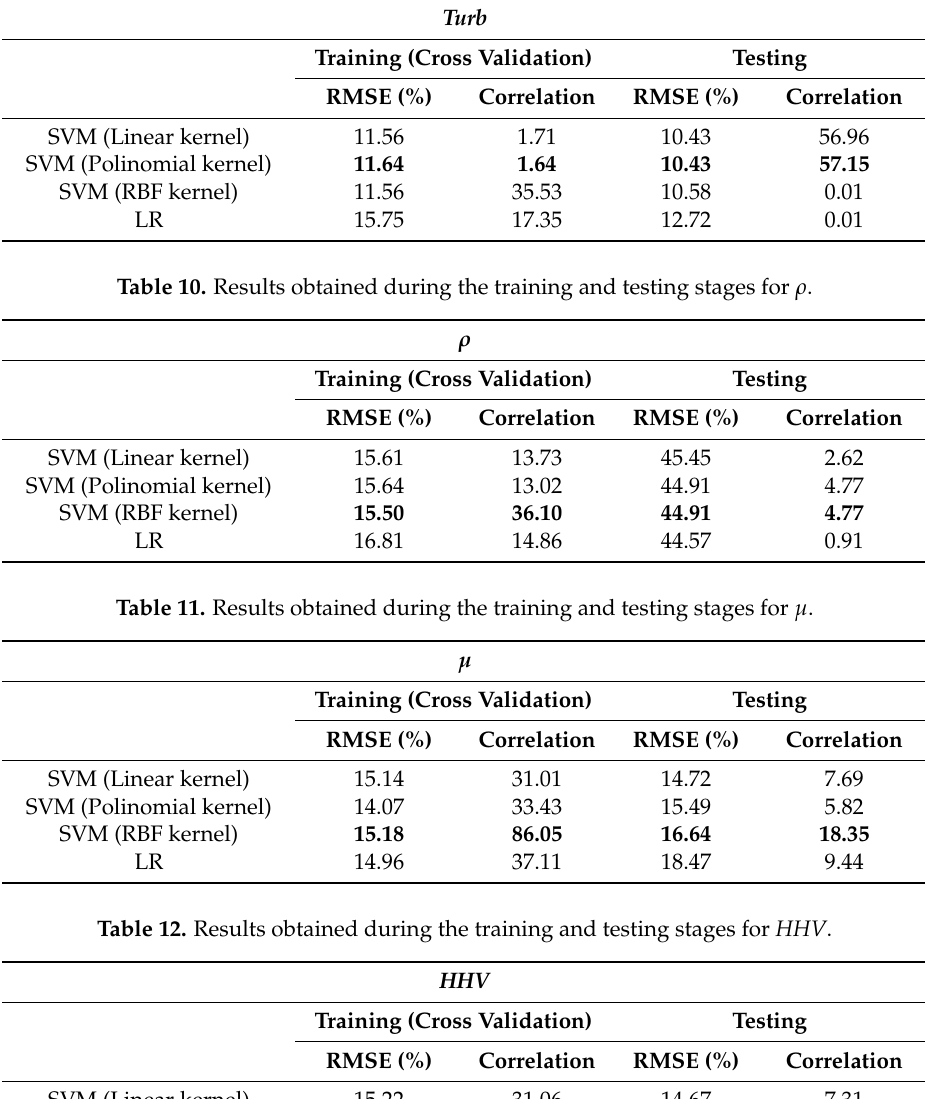
Table 9. Results obtained during training and testing stage for Turb .